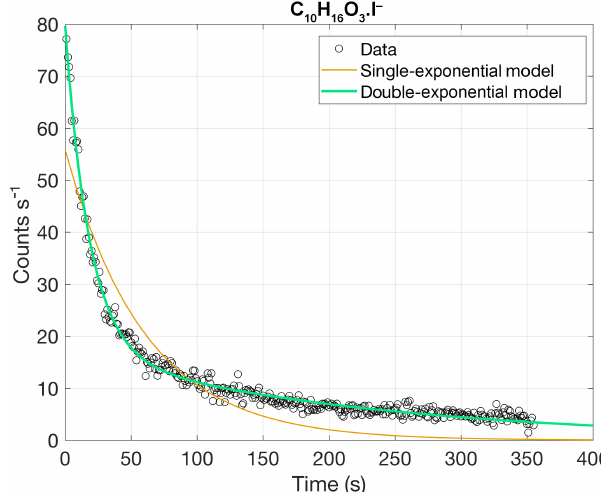
Figure 2. Decay of the signal for pinonic acid (detected as C 10 H 16 O 3 .I − ) during one of the experiments comprising a blank aerosol collection period, i.e., with a particle filter in the sampling line, followed by desorption at room temperature. The brown line is the fit obtained using Eq. (8); the green line fit was obtained using Eq.